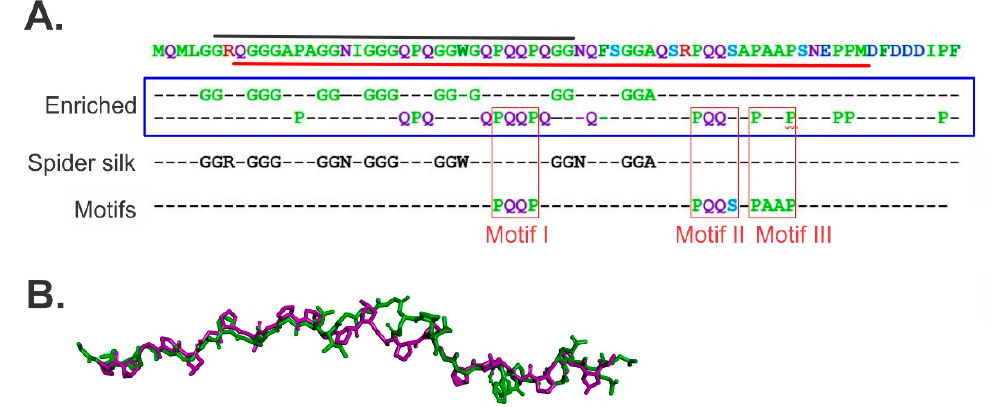
Figure 3. The linker domain of SSB contains sequence elements critical to its function . ( A ). The sequence of the C-terminal 69 residues of E. coli SSB is presented in the first line. The black line above the sequence corresponds to the putative polyproline type II helix, which terminates at residues 148 and 149 as these are known to disrupt these helices [72]. The red line demarcates the residues that form the linker domain. Enriched, the most over-represented residues highlighted in lines a and b. Residues 148 and 149 are highlighted to indicate where the PPII-helix would. Sequence analysis of the protein was done using REPRO at http://www.ibi.vu.nl/programs/ to determine the presence of repetitive elements. The spider silk sequence motifs that are repeated seven times are indicated. The location of the three PXXP motifs is highlighted by the red boxes. ( B ). Homology modeling reveals that residues 116–145 can adopt a collagen-like structure. The model of the N-terminal part of the SSB linker (green) is shown superimposed onto a collagen strand (purple).